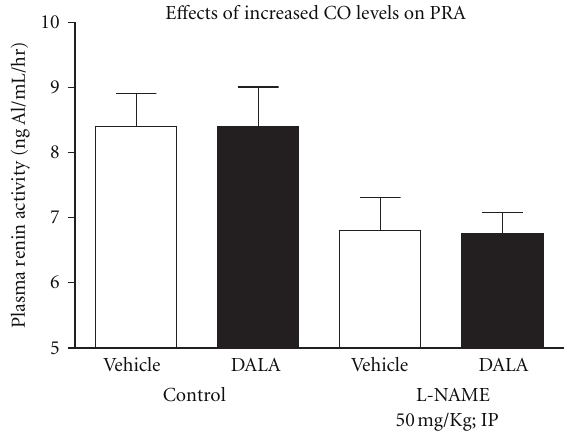
Figure 5: Acute administration of DALA (80 μ mol/kg; IP) did not exert significant e ff ects on plasma renin activity (PRA) in L-NAME- pretreated and -untreated rats. Vehicle and DALA changes in PRA were observed for 30-minute periods. Values are mean ± SE; n =